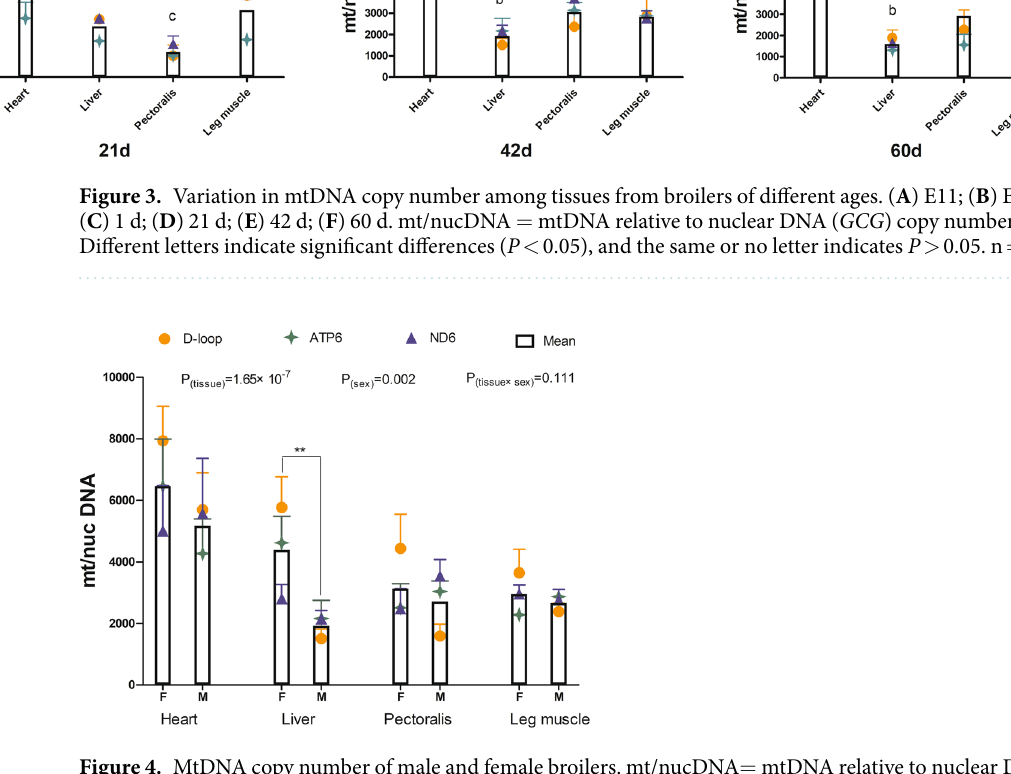
(Fig. 4). Overall, the mean number of mtDNA copies in female broilers was higher than that in male broilers (Fig. 4) and was approximately two times that in male broilers in the liver ( P < 0.01). Effects of feed restriction on the growth and mtDNA copy number of 21 d broilers. there were significant differences in body weight among the three feed restriction groups at 21 d, with protein restriction (PR) > energy restriction (ER) > quantitative restriction (QR). The growth of broilers in the QR group was seriously retarded: the body weight of the QR group was only 57.5% of that of the control group, and the liver weight, heart weight, pectoralis weight, and leg muscle weight of the QR group were significantly lower than those